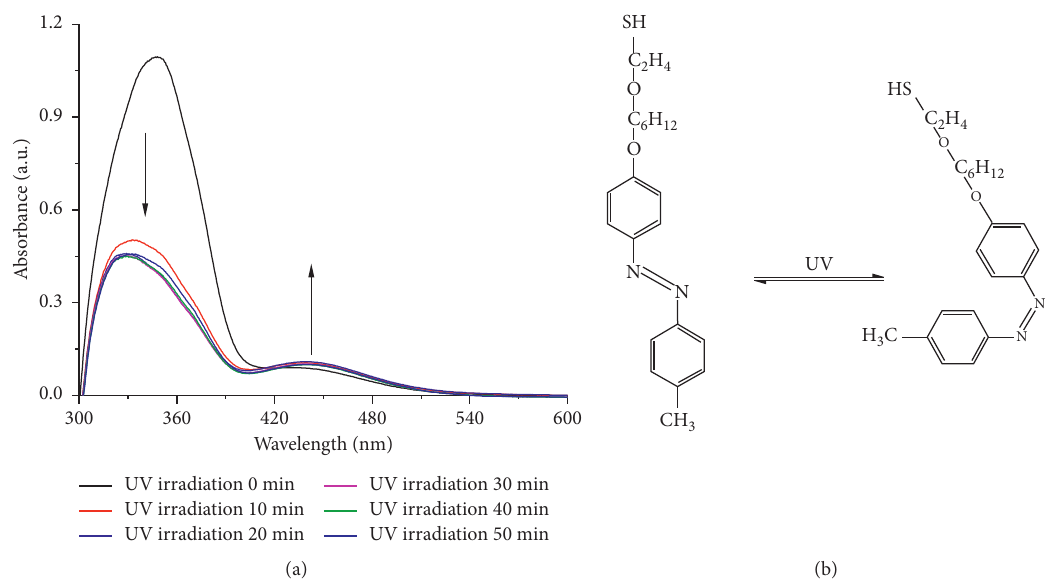
Figure 3: (a) UV-Vis spectra of Azo in chloroform (CDCl light (365nm)